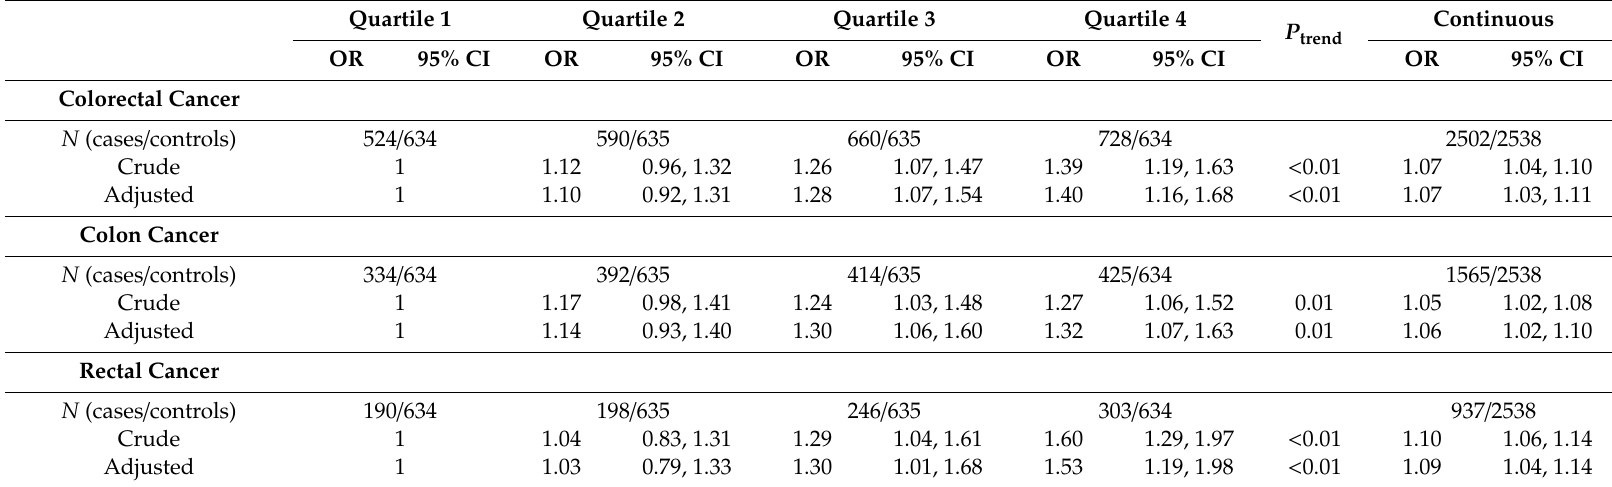
Table 3. Odds ratios and 95% confidence intervals of colorectal cancer for the energy-adjusted dietary inflammatory index (E-DII) score among cases and controls in a Chinese case-control study, 2010–2019 a